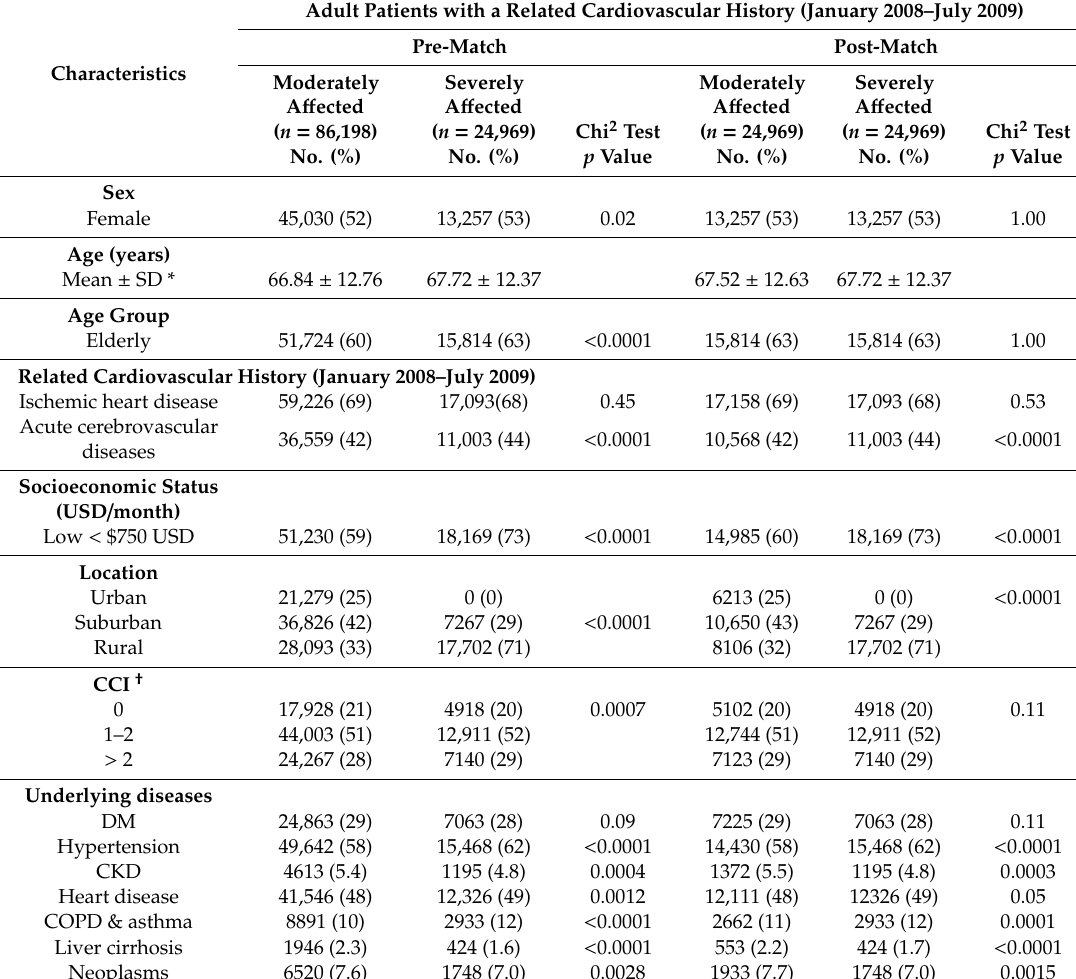
Table 2. Demographics of a ff ected adults before and after